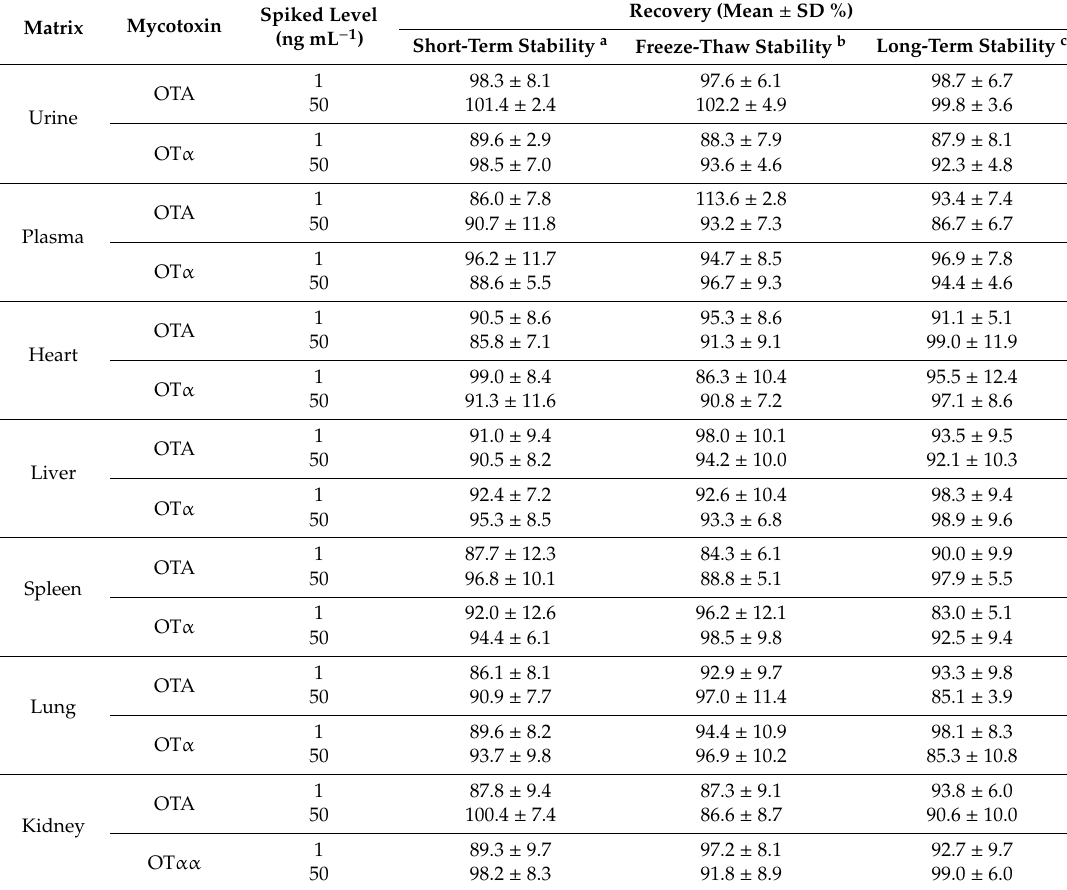
Table 3. Stability of ochratoxin A (OTA) and ochratoxin α (OT α ) in di ff erent biomatrices ( n =